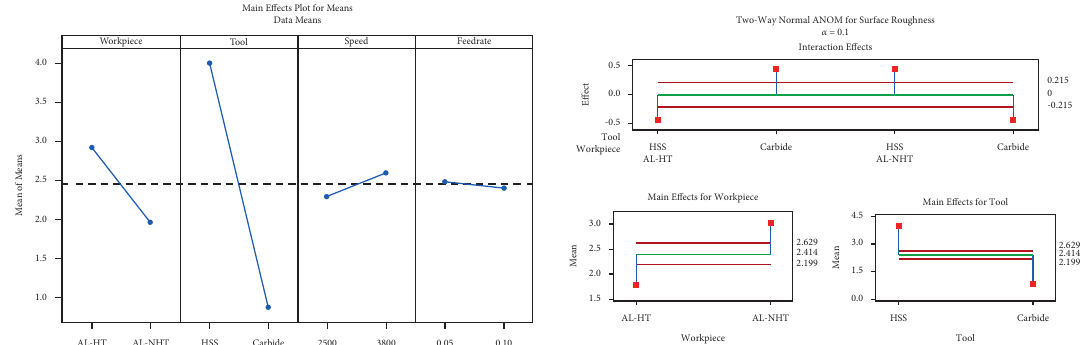
Figure 4: Effect of process parameters over the surface roughness by main effects plots and interaction plots for surface roughness.